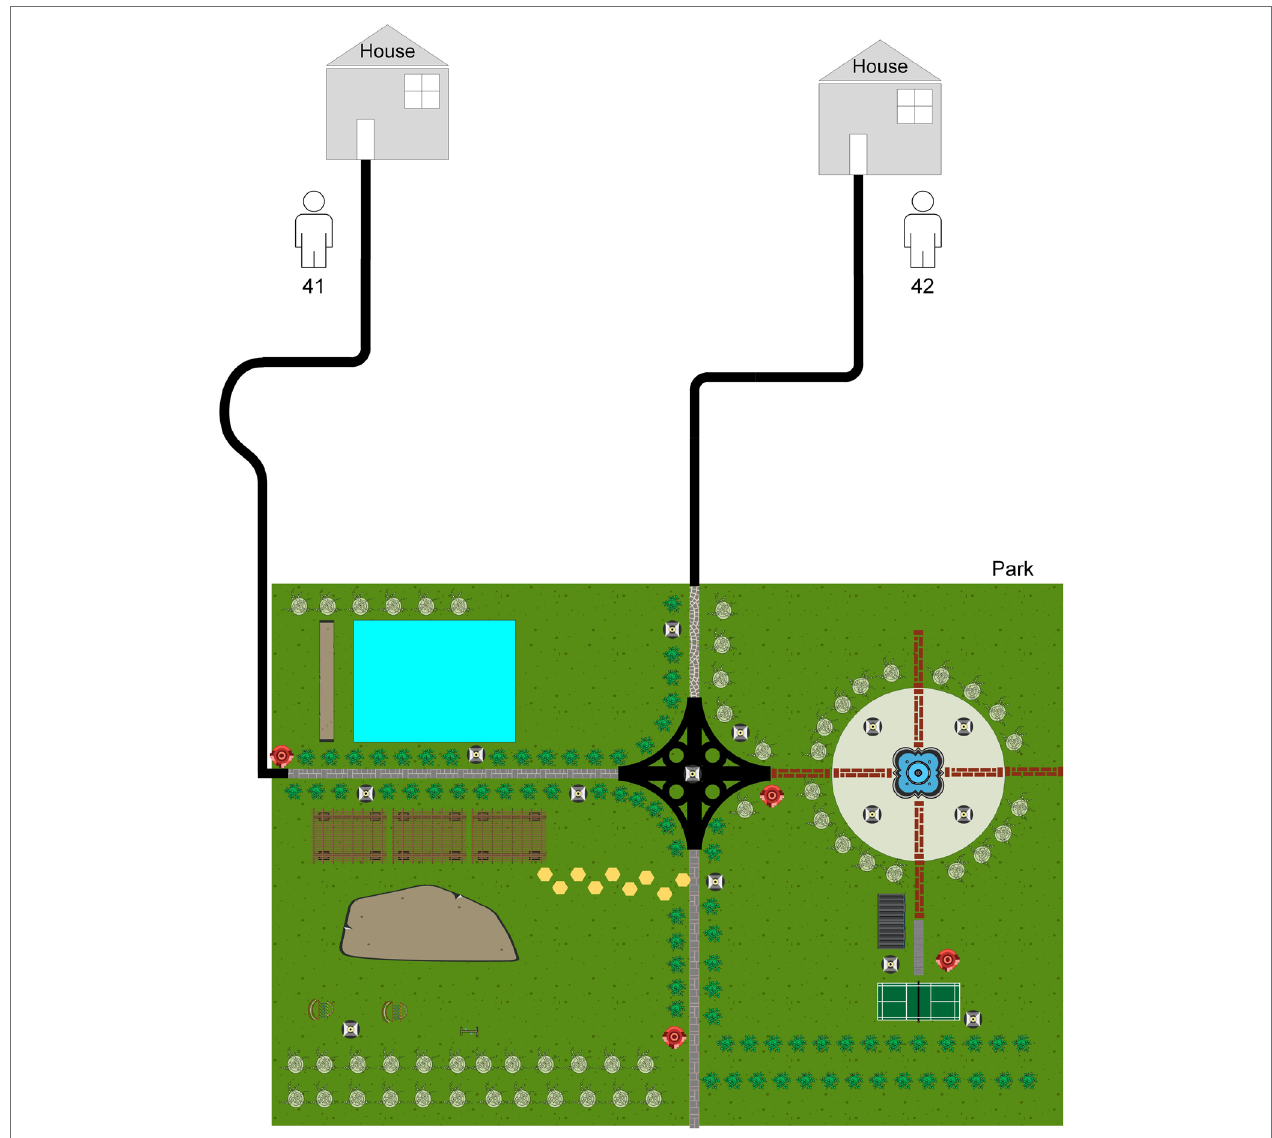
FIGURE 5 | Transmission network based on epidemiological